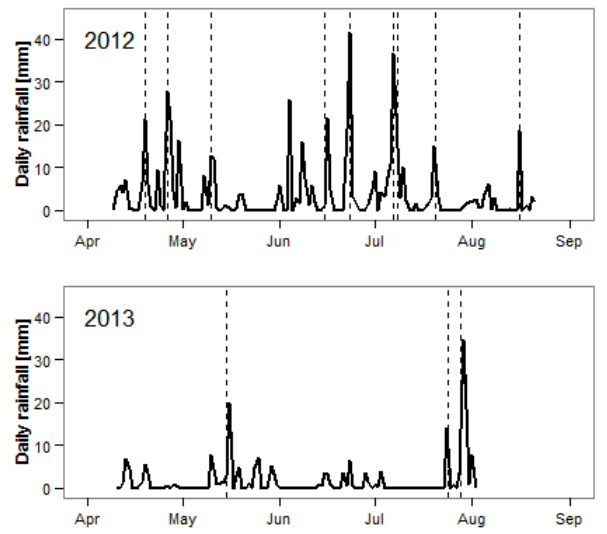
Figure 3. Time series of network average daily rainfall in the two seasons of 2012 and 2013 with vertical dashed lines indicating the events presented in Table